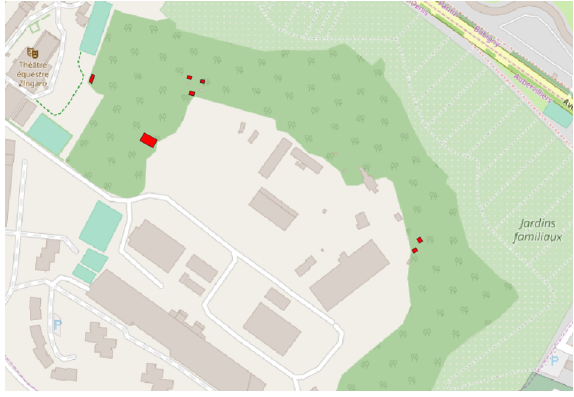
Figure 11. False positives detected by the model trained on Aubervilliers and applied to the neighbouring city of Pantin, caused by the n _ is _ within _ lulc